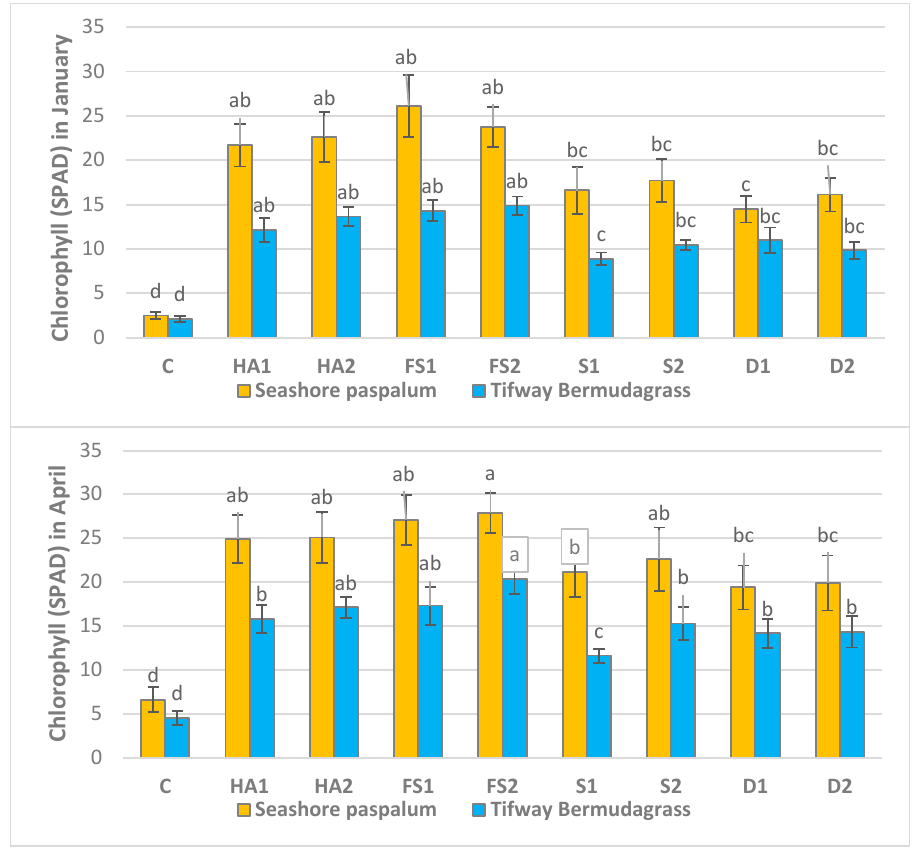
Figure 4. Mean values of chlorophyll content in leaves in both January and April (SPAD value ± SE) for seashore paspalum and Tifway bermudagrass treated with different amendments; values represent a mean of the two seasons. C = control, HA = humic acid, FS = ferrous sulphate, S = silica, D = diatomite. For more details about the treatments, please refer to Table 1. Data are presented as mean ± standard error of the mean, with the letter(s) from the species-wise Duncan’s multiple range tests indicated at the top of each bar.